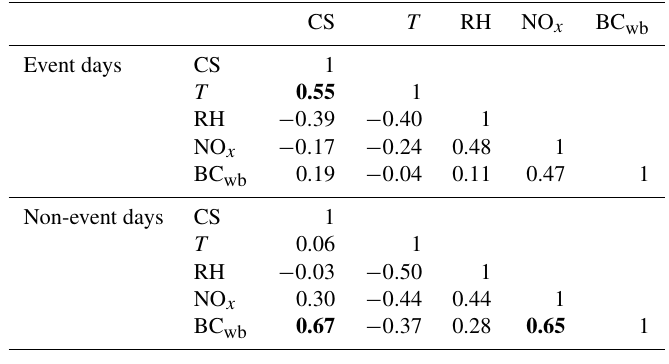
Table 1. Correlation coefficients between different meteorological parameters ( T , RH), nitrogen oxides (NO x ), black carbon concentrations from wood burning (BC wb ), and the total condensation sink (CS) during NPF event and non-event days for the 4-year period (2017–2020) and over the 09:00–14:00UTC time window. High positive or negative correlations are marked in bold.